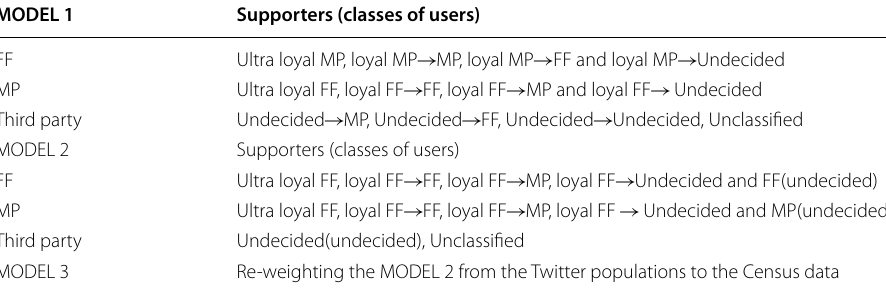
Table 5 The definition of three AI forecasting models based on the loyalty classes and network theoretical tools of homophily according opinion